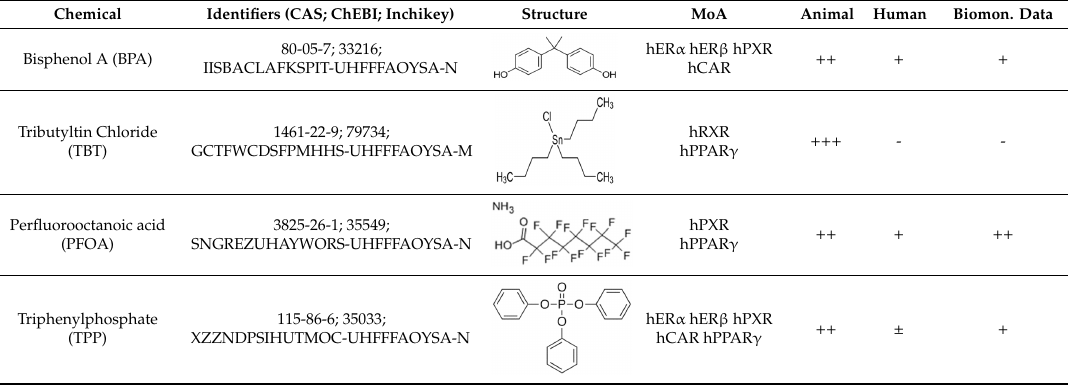
Table 1. Classes of MDCs and the initial set of model compounds that will be tested in GOLIATH, putative human nuclear receptor (NR)-mediated mechanism of action (MoA) and weight of evidence from animal and human studies as well as the availability of data on human exposure from biomonitoring studies. Chemical Identifiers (CAS; ChEBI;